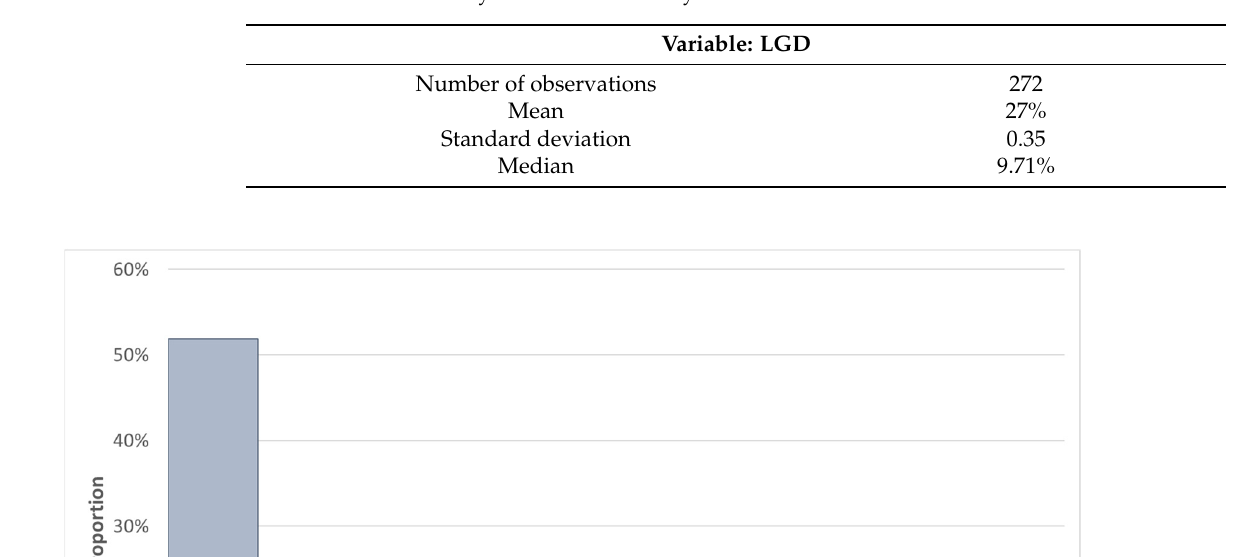
Table 12. LGD summary statistics of Country AH.